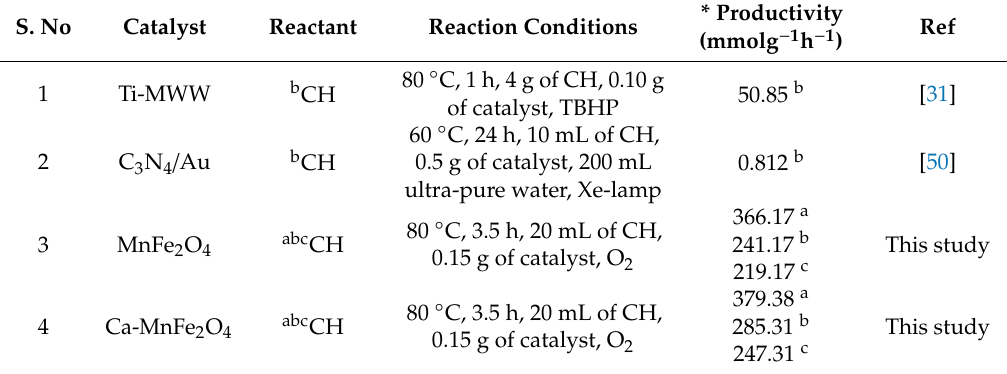
Table 1. Comparison of the catalytic activity of di ff erent catalysts being used for the oxidation of